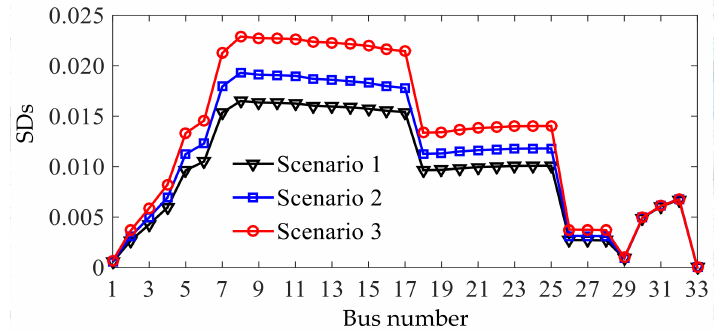
Figure 19. SDs of the voltage magnitudes in the electricity network.